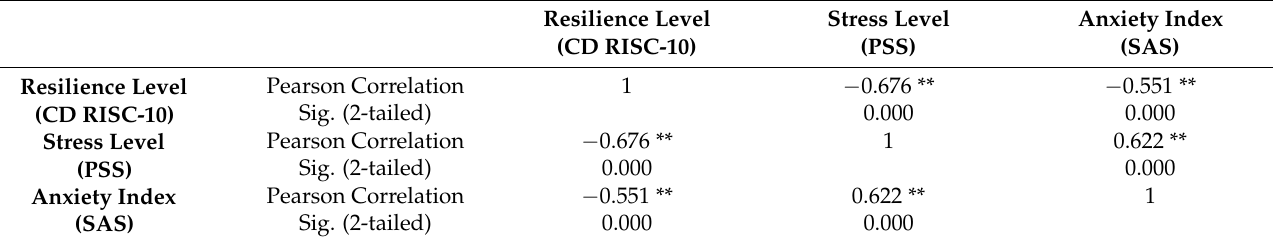
Table 6. Interscale